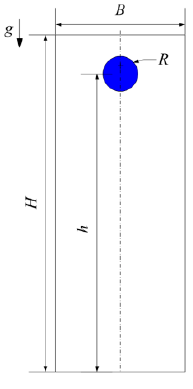
Figure 1. The geometric sketch of water droplet in an air pipe.